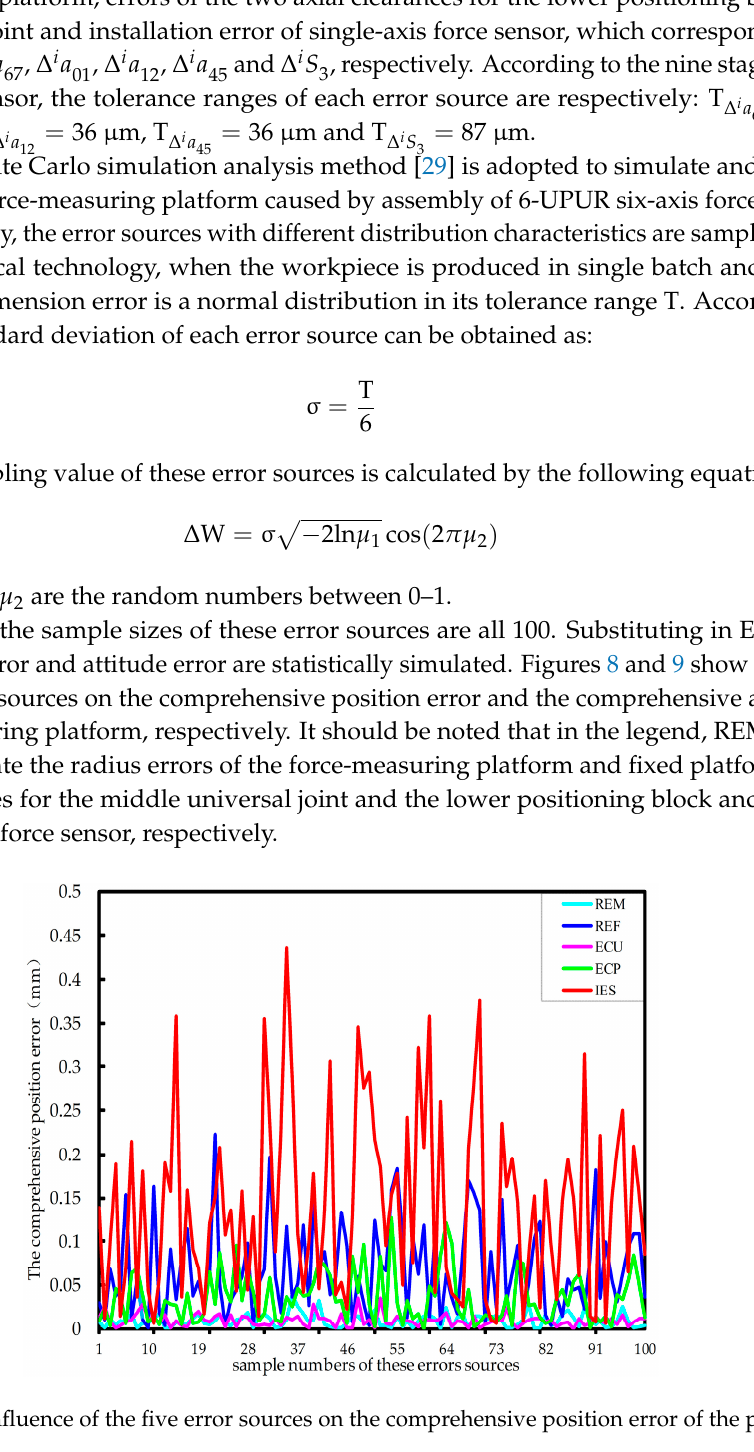
Figure 8. The influence of the five error sources on the comprehensive position error of the platform.